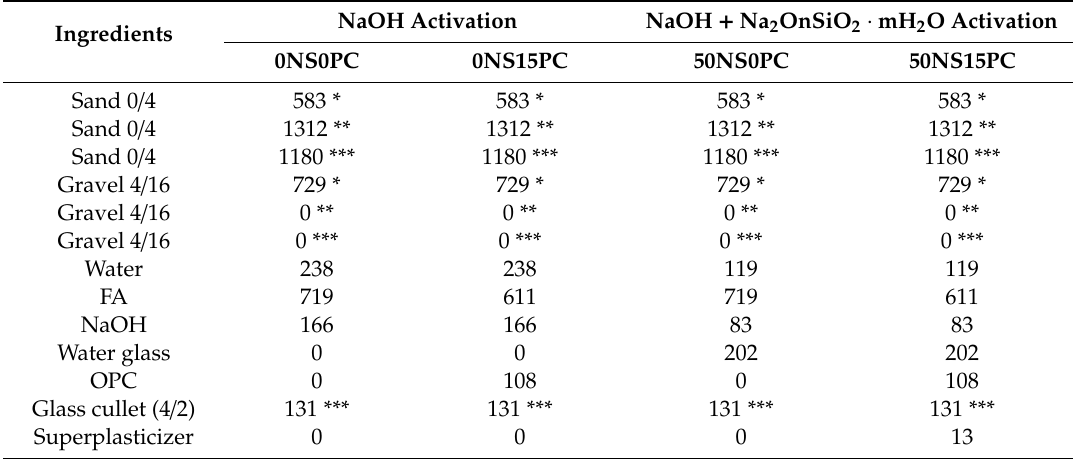
Table 2. The compositions (kg) for 1 m 3 concrete mixtures.